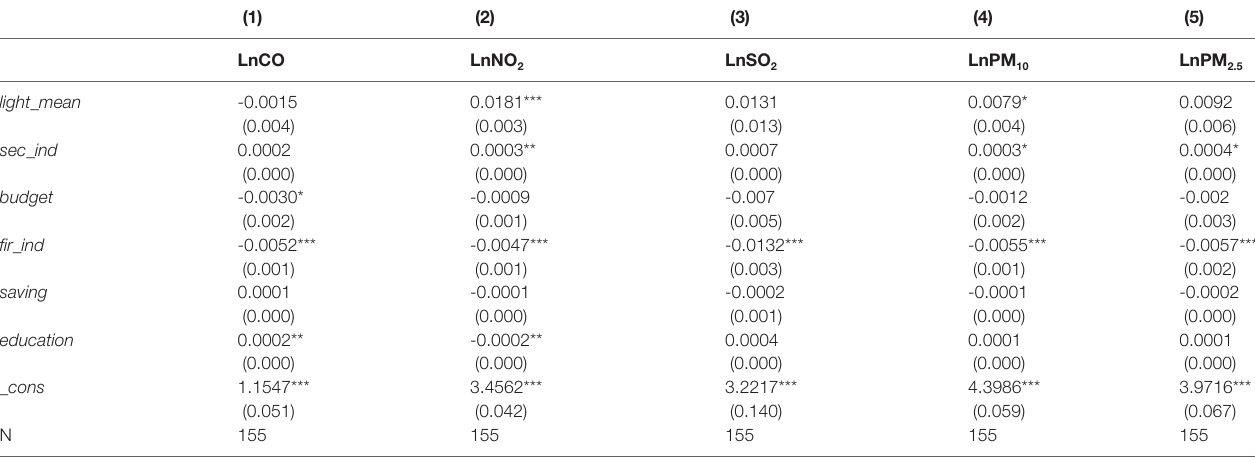
TABLE 10 | The impact of economic development on air pollutants with replacing explained variables.